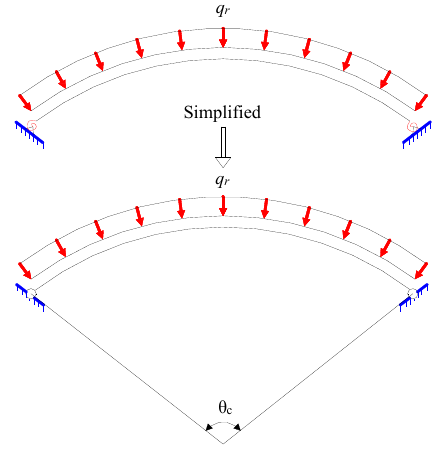
Figure 9. Simplified calculation model of the chord.